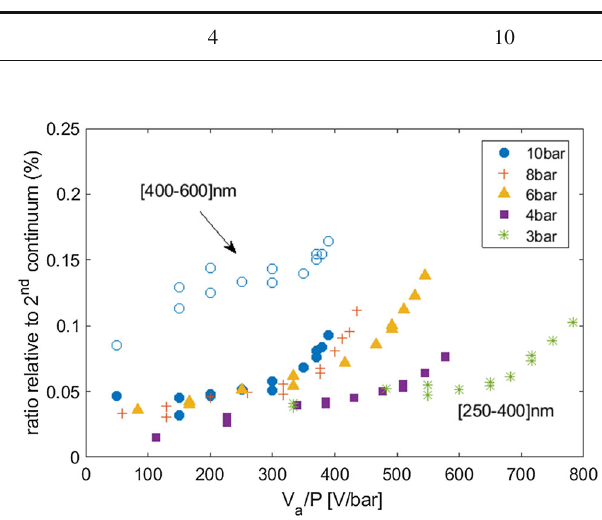
Fig. 19 Secondary scintillation yields in the UV region 250–400 nm for different pressures, relative to 2nd continuum scintillation (145– 250 nm). For illustration, the (stronger) emission in the visible 400– 600 nm band is shown too, for 10 bar. As the spectra of secondary emissionisnotknown,detected(photoelectron)ratiosareplottedandno QEcorrectionhasbeenattempted.For140–400 nm,wheretheresponse of the PM is largely flat, the scintillation ratio at production is expected to be within a factor × 2 of the values shown of the values shown, at